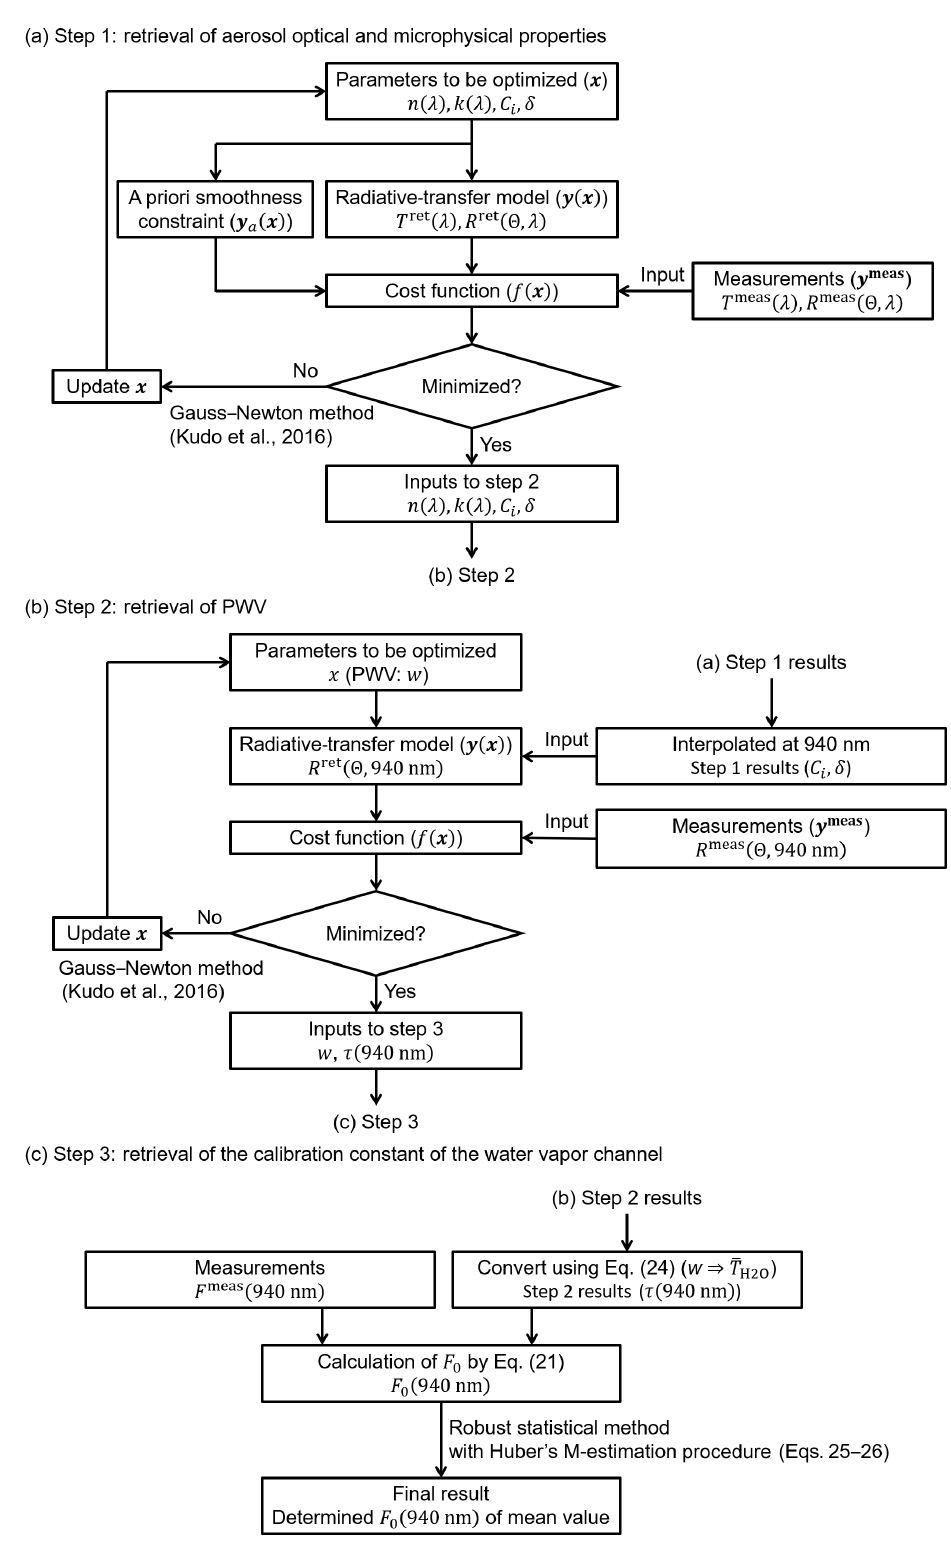
Figure 7. Schematic diagrams of SKYMAP procedures. (a) Step 1. (b) Step 2. (c) Step 3. Square boxes show the calculation and input–output